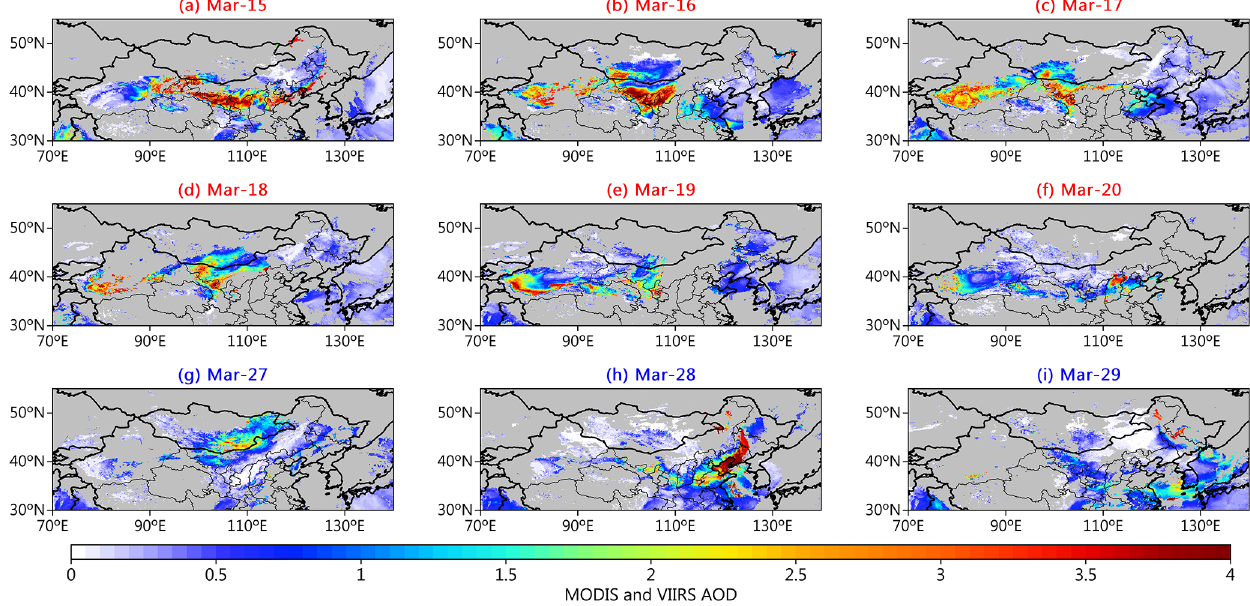
Figure 4. Evolution of MODIS and VIIRS combined daily mean AOD during (a–f) the 3.15 event and (g–i) the 3.27 event.